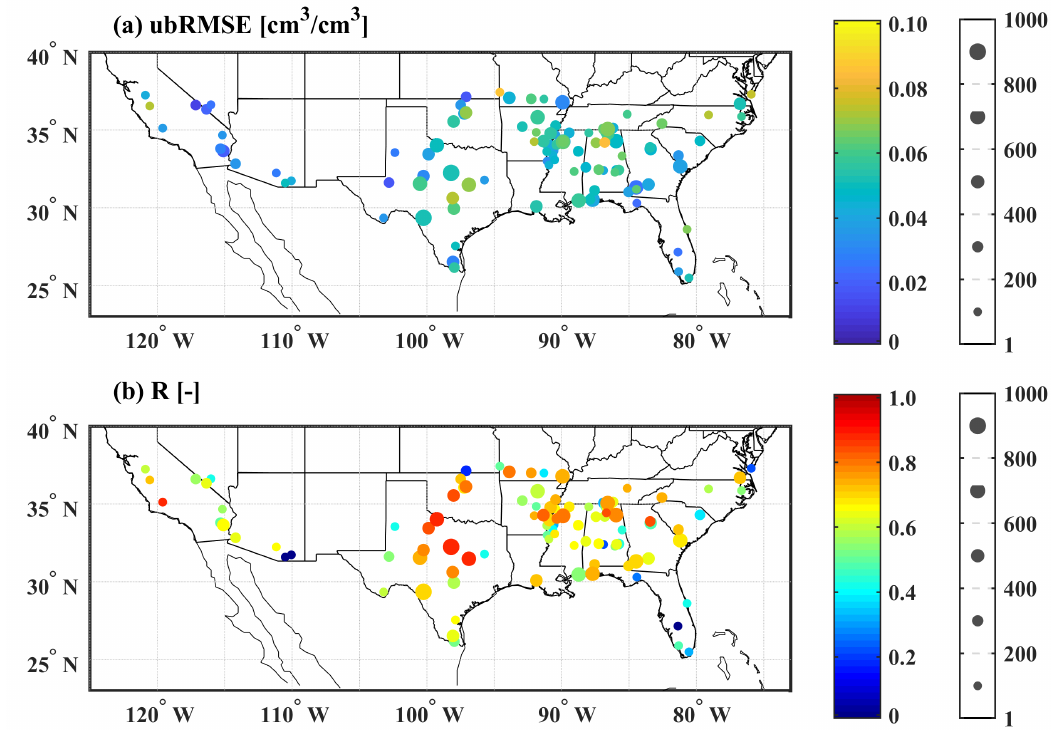
Figure 7. Spatial distribution maps of the ( a ) unbiased RMSE (ubRMSE) and ( b ) correlation coefficient (R) for all sites over contiguous U.S. The sizes of the filled circles are scaled as a function of the number of